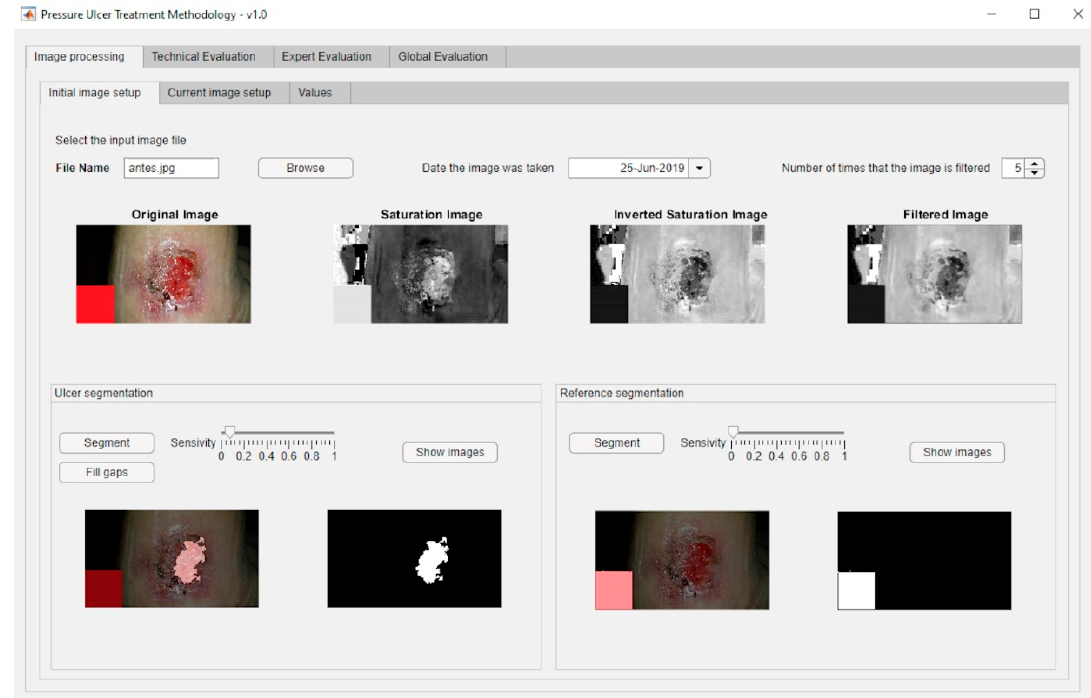
Figure 3. Dialog box for loading an image of the ulcer prior to the treatment.